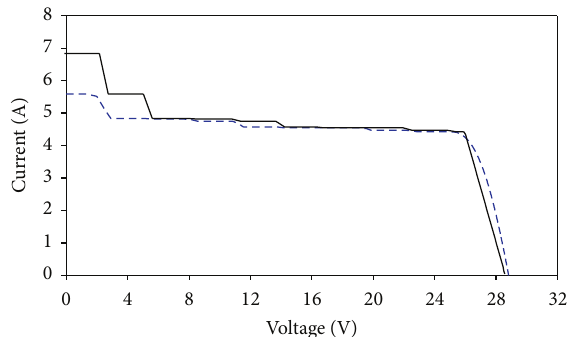
Figure 12: Matlab simulated I-V curve (blue dashed line) of the optimized dense-array is superimposed on FPM simulation curve (black line).